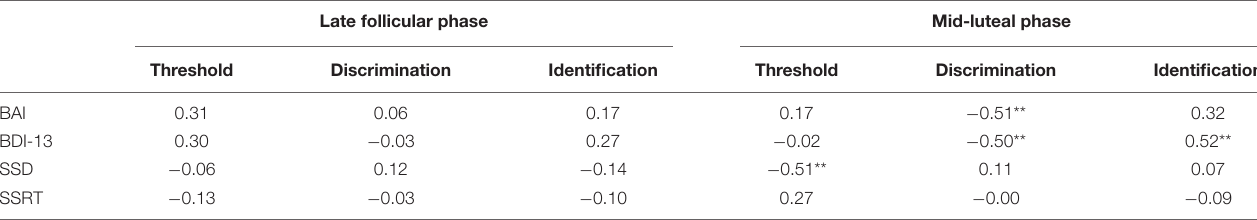
TABLE 1 | The bivariate relationships (expressed by Spearman’s ρ ) between emotional symptoms, behavioral impulsivity, and olfactory